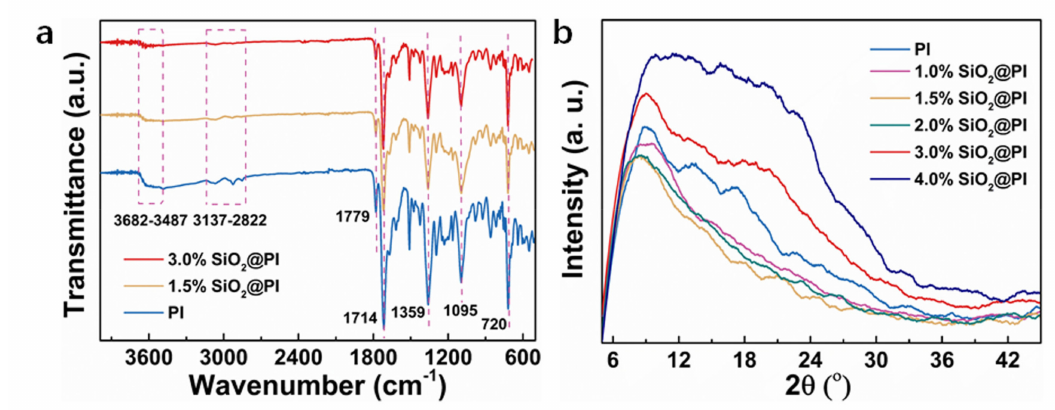
Figure 4. ( a ) FTIR spectra and ( b ) XRD patterns of PI and SiO 2 @PI hybrid